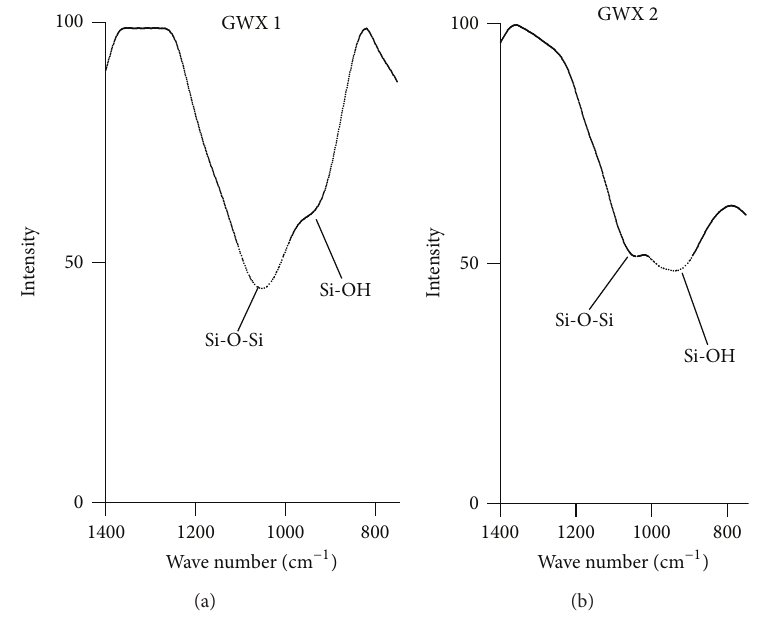
Figure 5: Infrared spectra of GWX 1 and GWX 2 cements at 1 day ageing time.